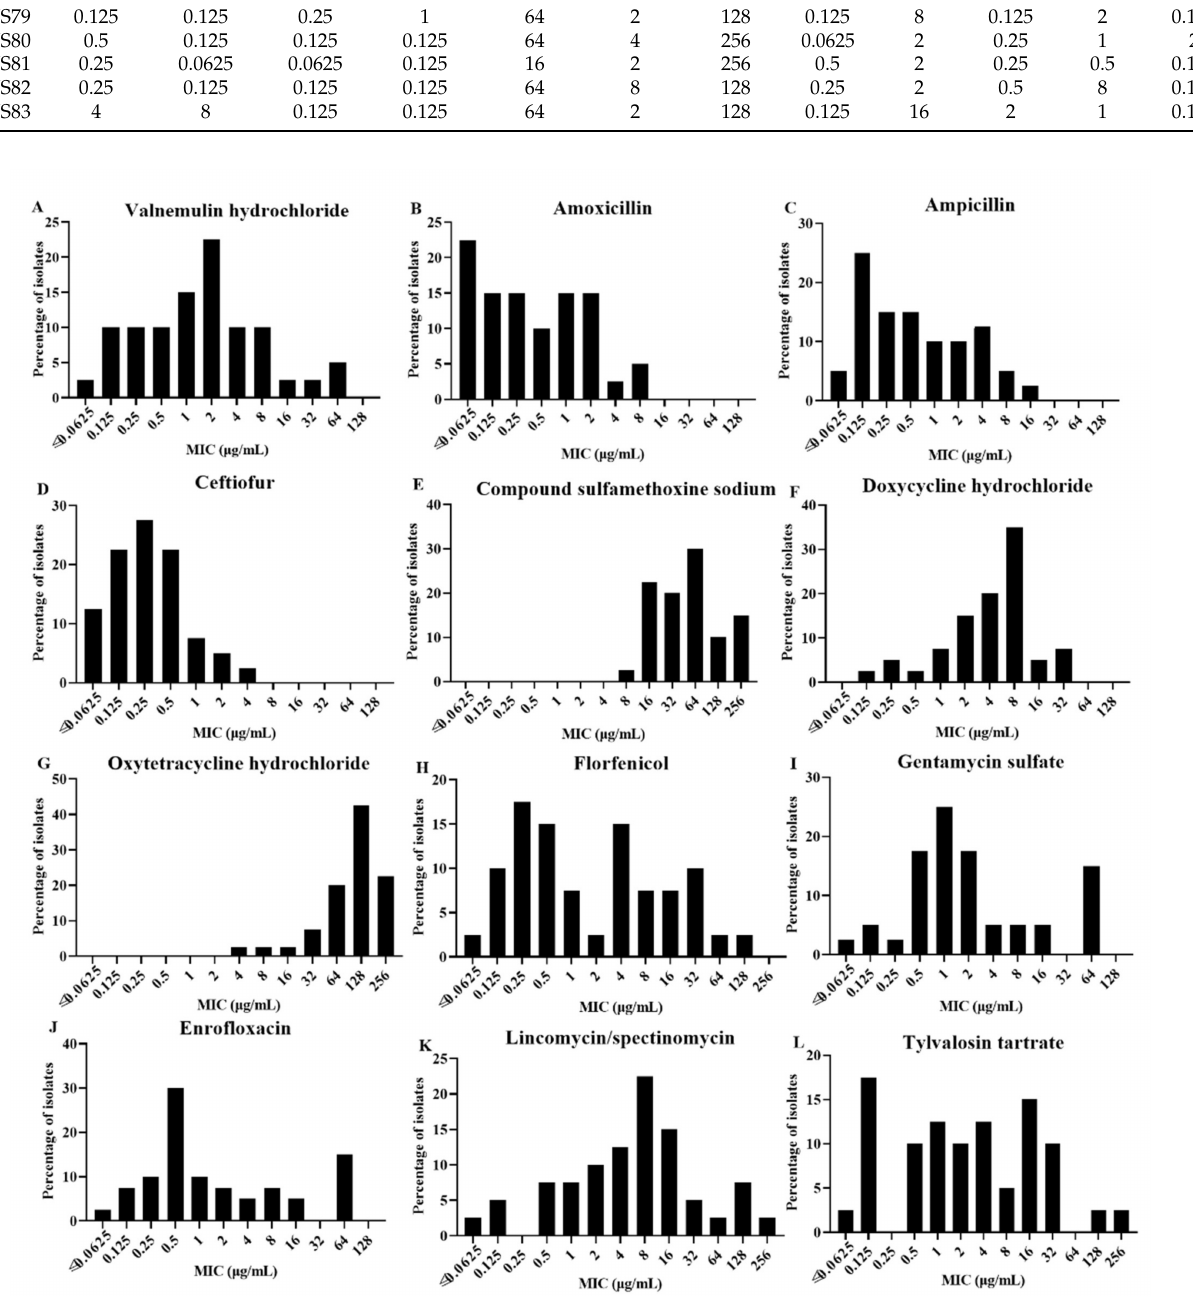
Figure 1. Distribution of minimum inhibitory concentration values of antimicrobial agents tested: ( A ) alnemulin hydrochloride, ( B ) amoxicillin, ( C ) ampicillin, ( D ) ceftiofur, ( E ) compound sulfamethox- ine sodium, ( F ) doxycycline hydrochloride, ( G ) oxytetracycline hydrochloride, ( H ) florfenicol, ( I ) gen- tamycin sulfate, ( J ) enrofloxacin, ( K ) lincomycin/spectinomycin, and ( L ) tylvalosin